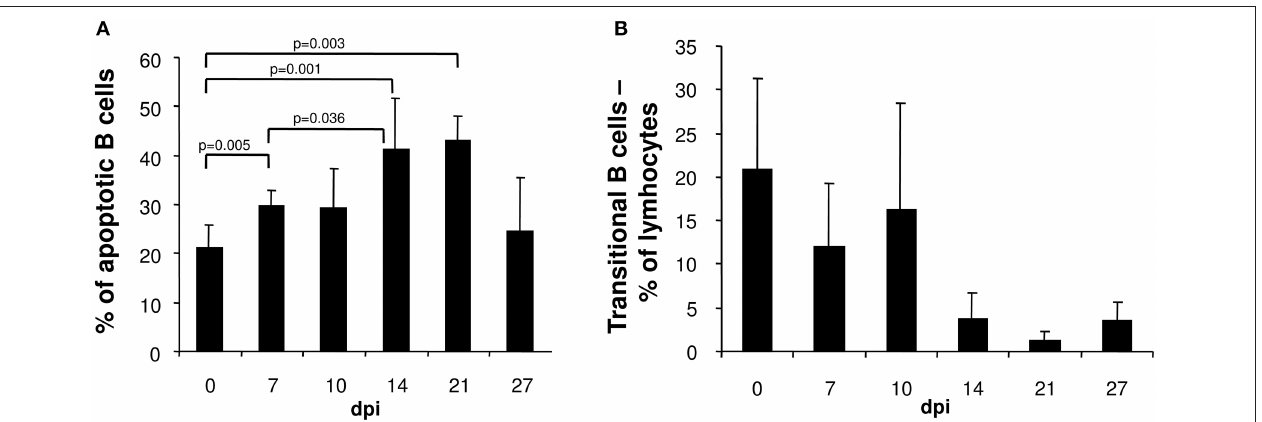
FIGURE 2 | In the spleen of T. cruzi -infected mice the frequency of apoptotic B cells is elevated whereas the proportion of transient B cells is reduced. C57BL/6 mice were infected with 75 T. cruzi blood trypomastigotes i.p.. At the indicated time points, spleen cells were analyzed by flow cytometry. (A) Frequency of merocyanine + apoptotic B220 + cells. (B) Proportion of B220 + IgM hi transitional B cells. Data represent mean ± SD of pooled results from three independent experiments each comprising 5 mice per time point. Statistical analysis was performed using two-tailed Student’s t